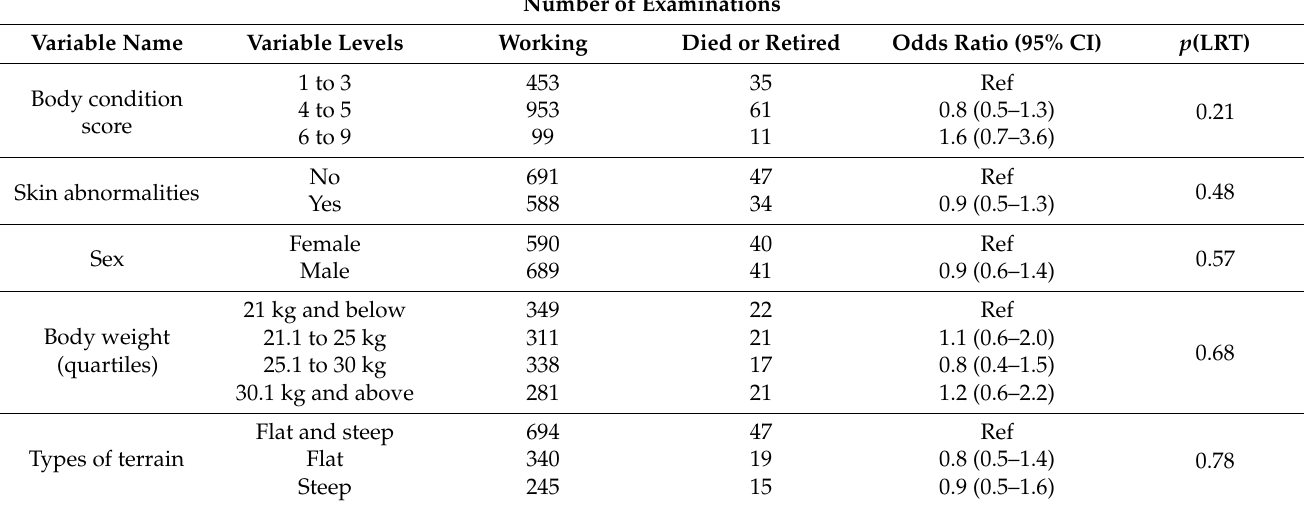
Table 7. The results of univariable screening of potential explanatory variables for the risk of examinations being followed by dogs dying, being euthanized or being retired. The p -values derived from log-likelihood ratio tests of univariable logistic regression models examining the association between potential explanatory variables and the risk of examinations being followed by dogs dying or being retired. The listed explanatory variables were not included in multivariable analysis as they had p -values larger than 0.2. Data are from 1360 examinations of 589 dogs, of which 81 examinations were followed by a dog dying or being retired. All dogs were enrolled in the TeamMate project and all examinations had recorded values for all tested